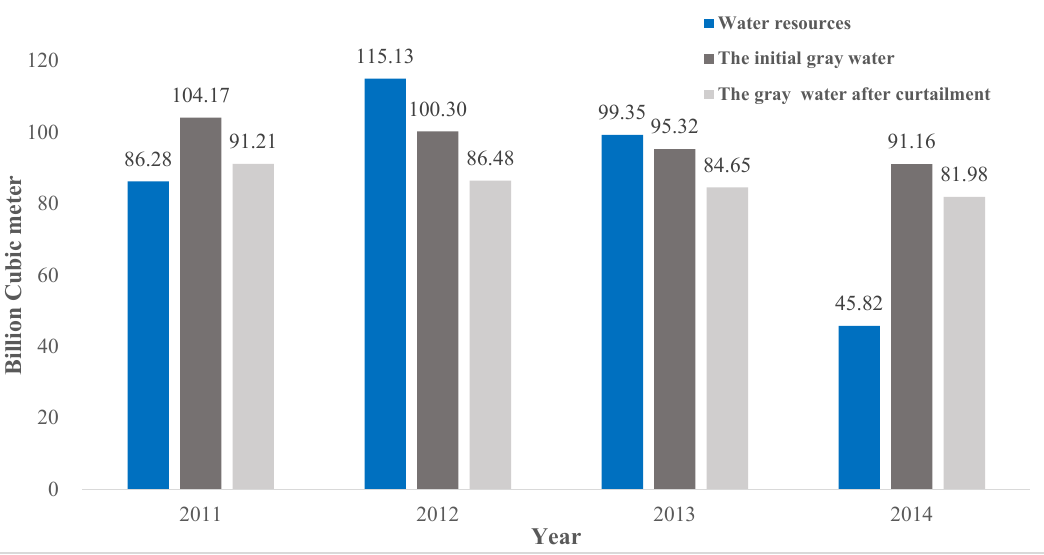
Figure 4. A comparison of water resources amount, the initial gray water footprint, and gray water footprint after curtailment of Bohai Economic Zone from 2011 to 2014.